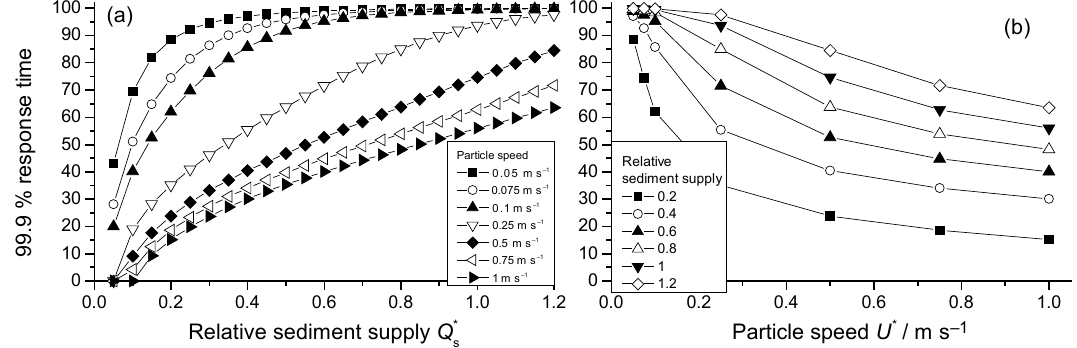
Figure 12. Dimensionless time to reach 99.9% of the total adjustment in the exposed area as a function of (a) transport stage and (b) particle speed. All simulation were started with A ∗ = 1 and M ∗ m = M ∗ s = 0.